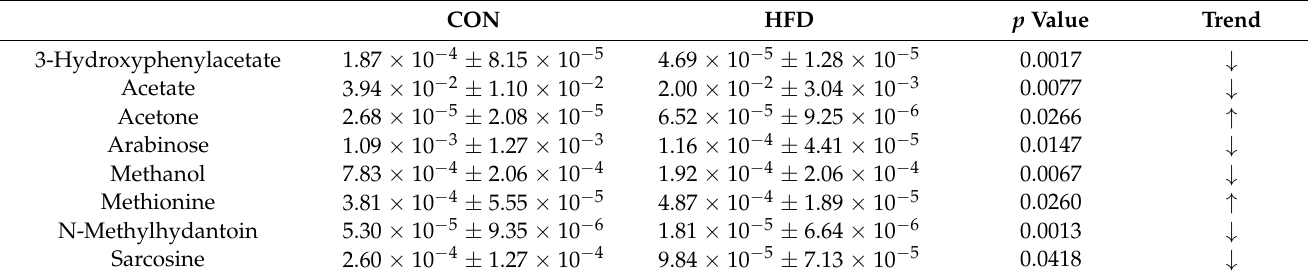
Table 1. Molecules with significant differences in cecum contents of CON and HFD groups.